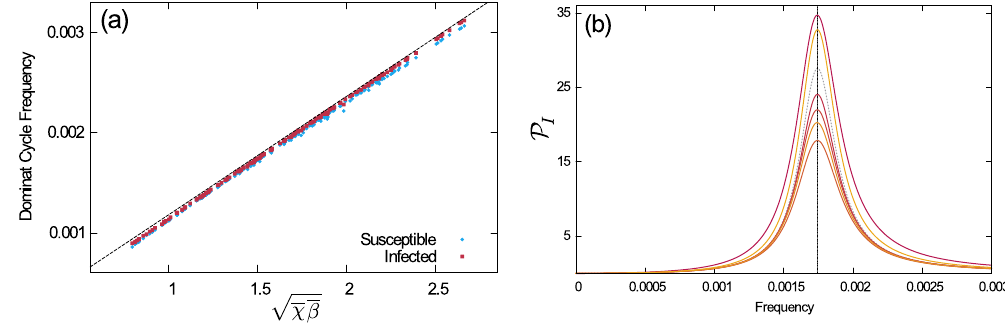
Figure 4. Verification of approximation (18) for the dominating frequency of cycles. (a) Frequency ω π = f /2 at the maximum of the PSD, determined from Eq. (S10) as a function of χβ , for fixed κ . The black dashed line corresponds to Eq. (18). Markers are from 200 different populations, each with 5 susceptible and 3 infected β χ β . The values of χ subgroups, and with random choices of p q { , , , } i and a were chosen from the interval i i a a 1.7 ± 1.6999995; q a and p i from a flat distribution. This resulted in values of χ and β in the range 0.3 to 3.3, and for χ 2 and β 2 in the range 0.1 to 10. (b) PSD of the total infected population of different random distributions of χ β , with equal values for χ and β , but different values of χ 2 and 2 β . As a consequence of Eqs (18) p q { , , , } i i a a and (19), the characteristic frequency is the same for all such samples, but the height of the peak in the PSD varies considerably (the amplitude of the oscillations changes with the square root of the amplitude of the power spectra). The dashed grey line corresponds to the homogeneous model, i.e. K = M = 1. The vertical dotted line is a visual aid.